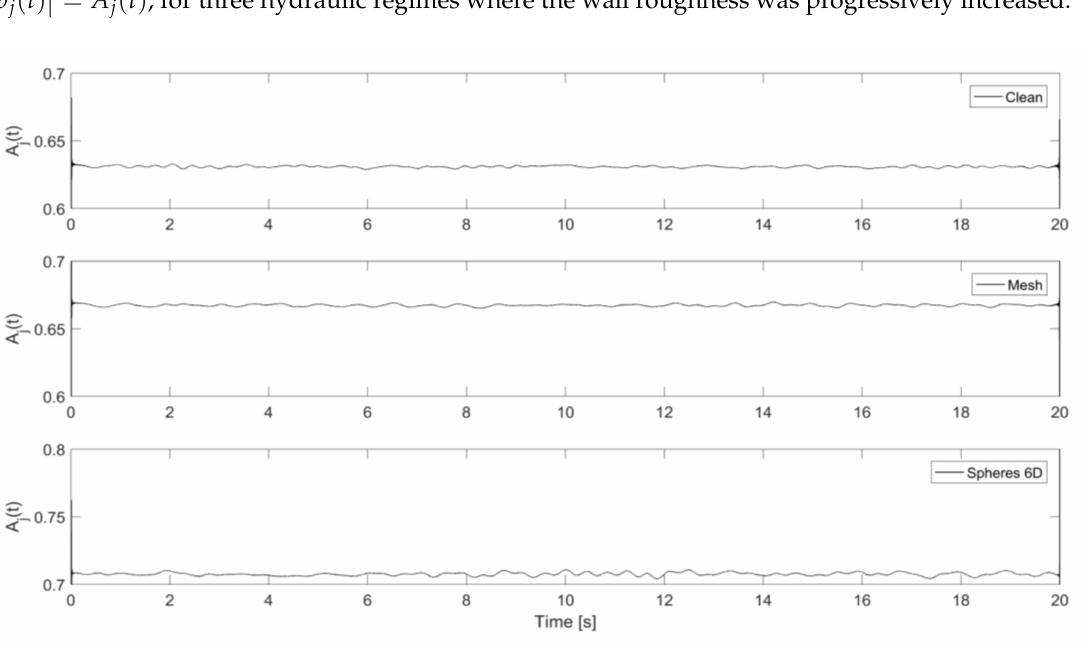
Figure 5. Examples of the continuous wave envelope recorded on microphone 1 for 20 s in the clean pipe at V = 0.24 m/s and h = 52 mm ( top ); pipe with the mesh at V = 0.21 m/s and h = 63 mm ( middle ); and pipe with 6D spheres arrangement at V = 0.20 m/s and h = 66 mm ( bottom